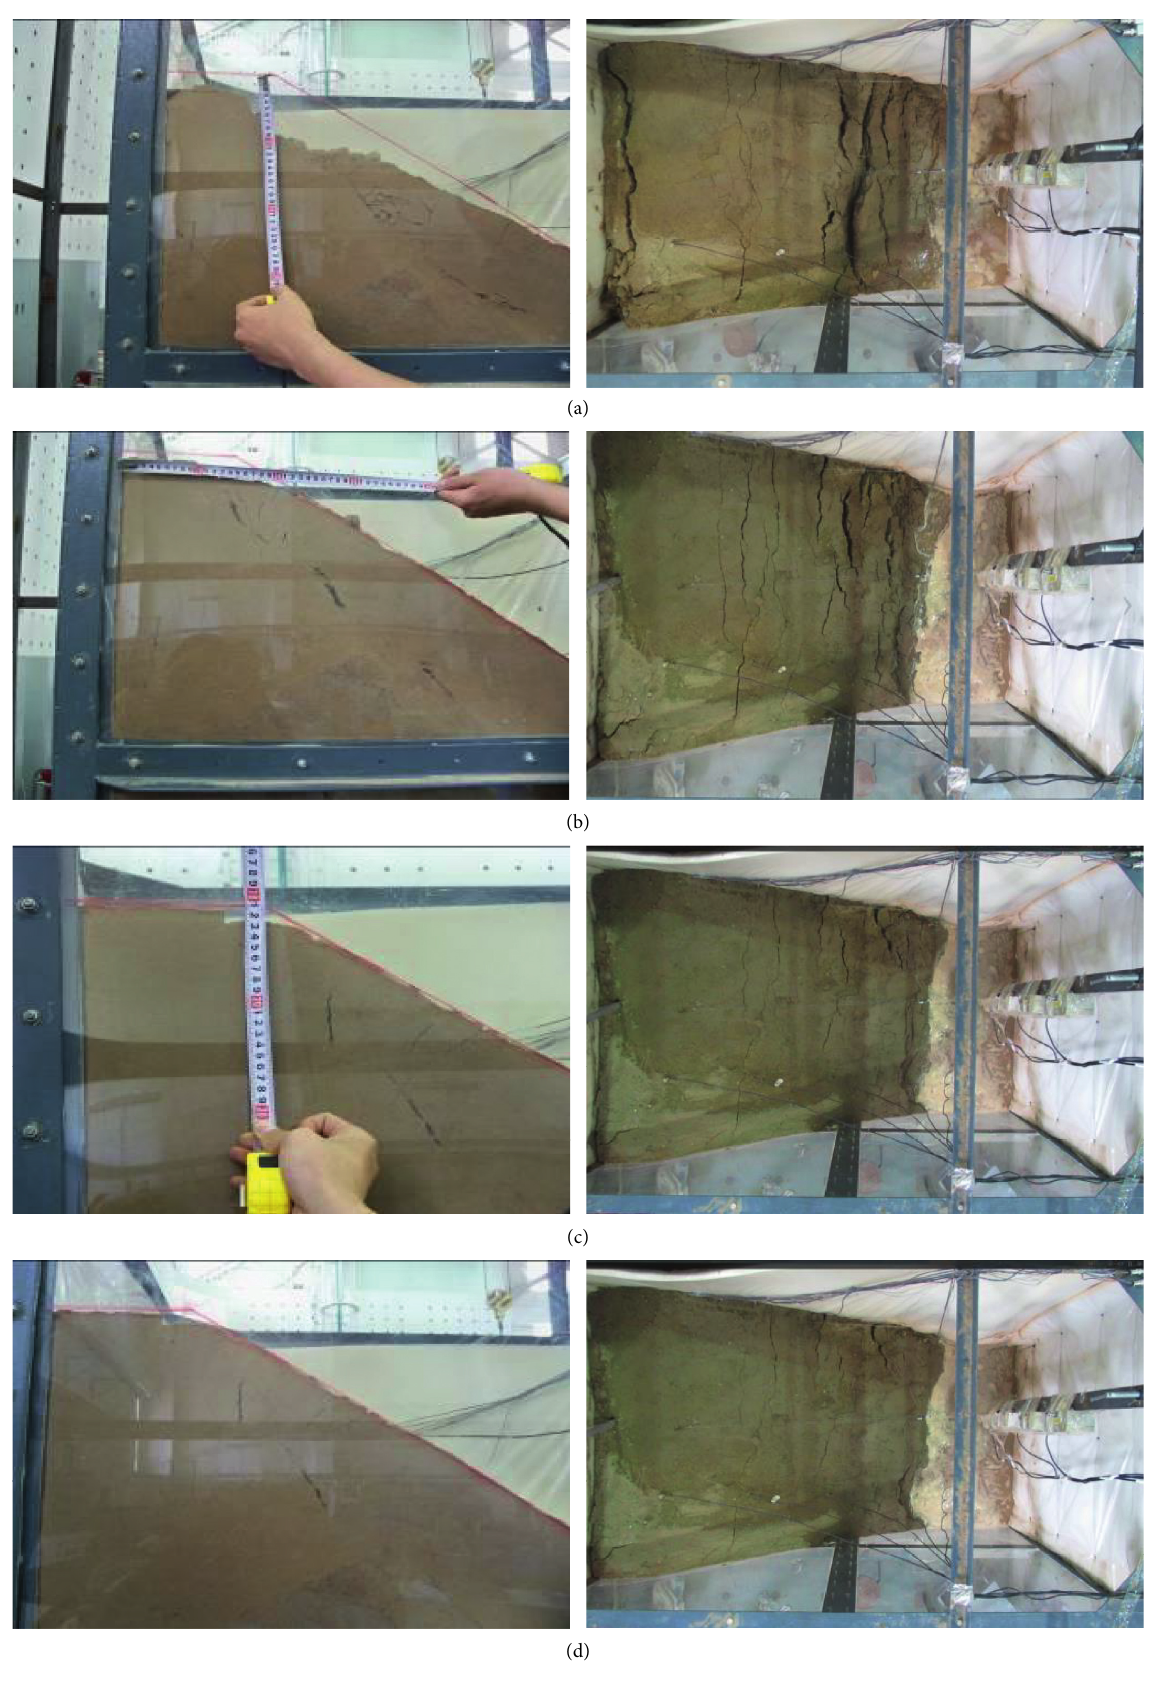
Figure 15: Plastic failure states with different stability levels. (a) Grade I. (b) Grade II. (c) Grade III. (d) Grade